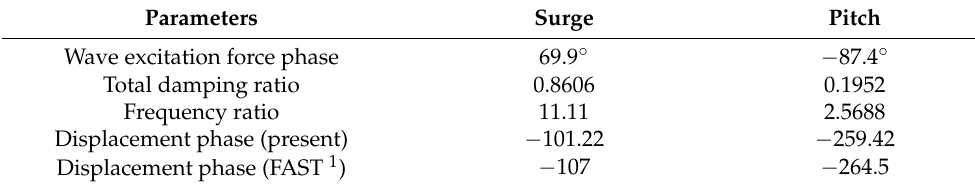
Table 8. Phase parameters of pitch and surge motions at 0.1 Hz.